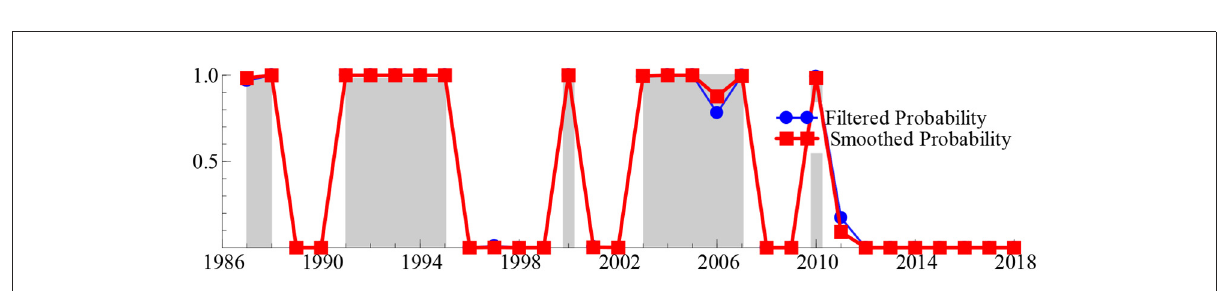
FIGURE5 The smooth probability time dynamic path of the fast-growth